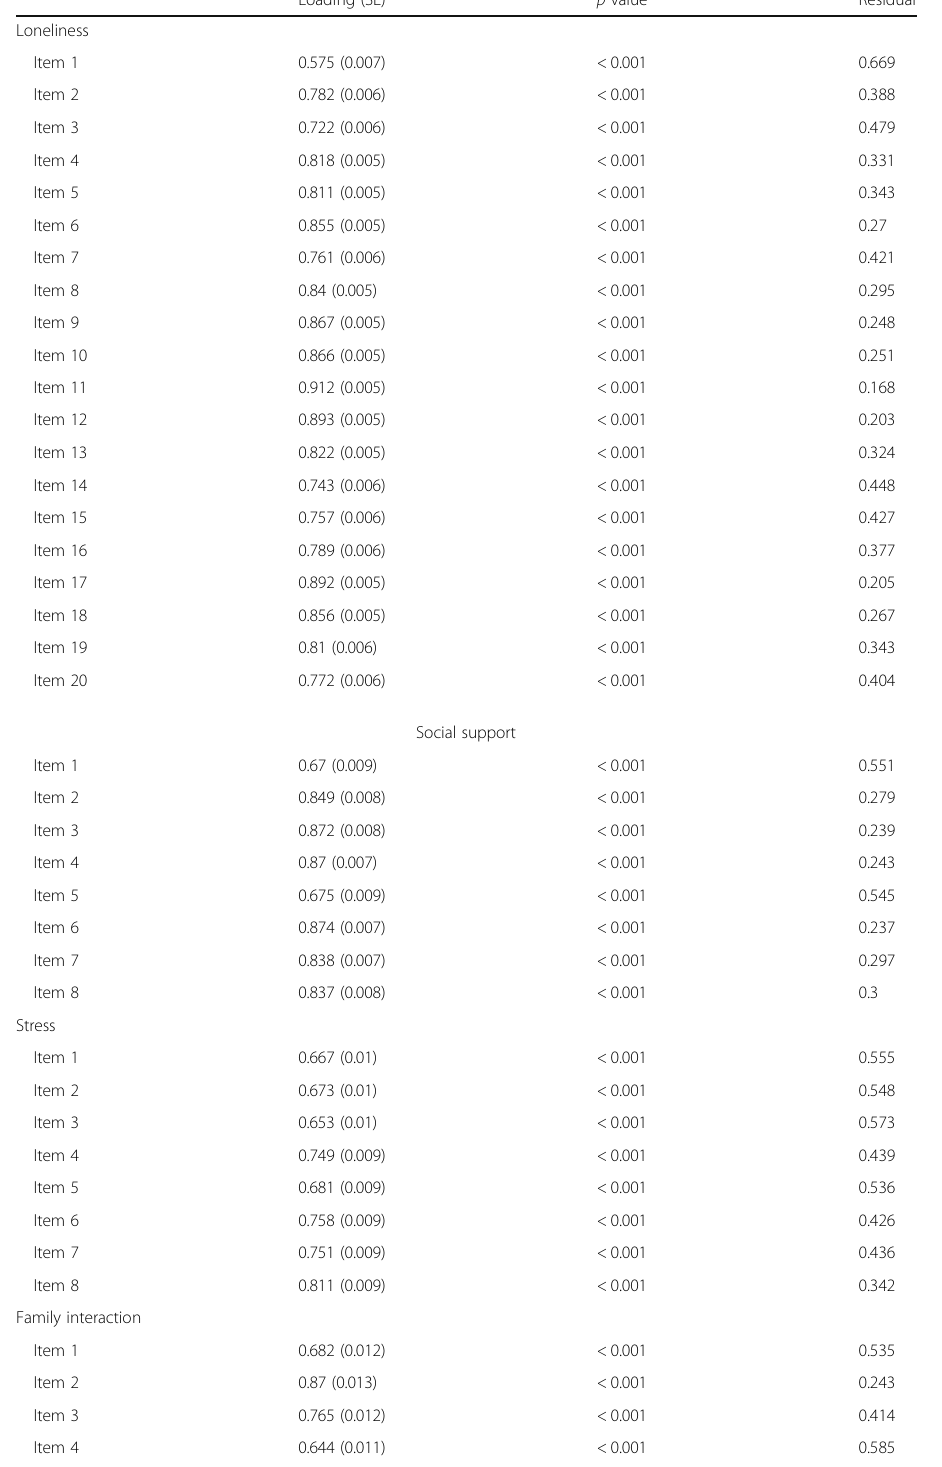
Table 2 Factor loadings and residuals for the observed